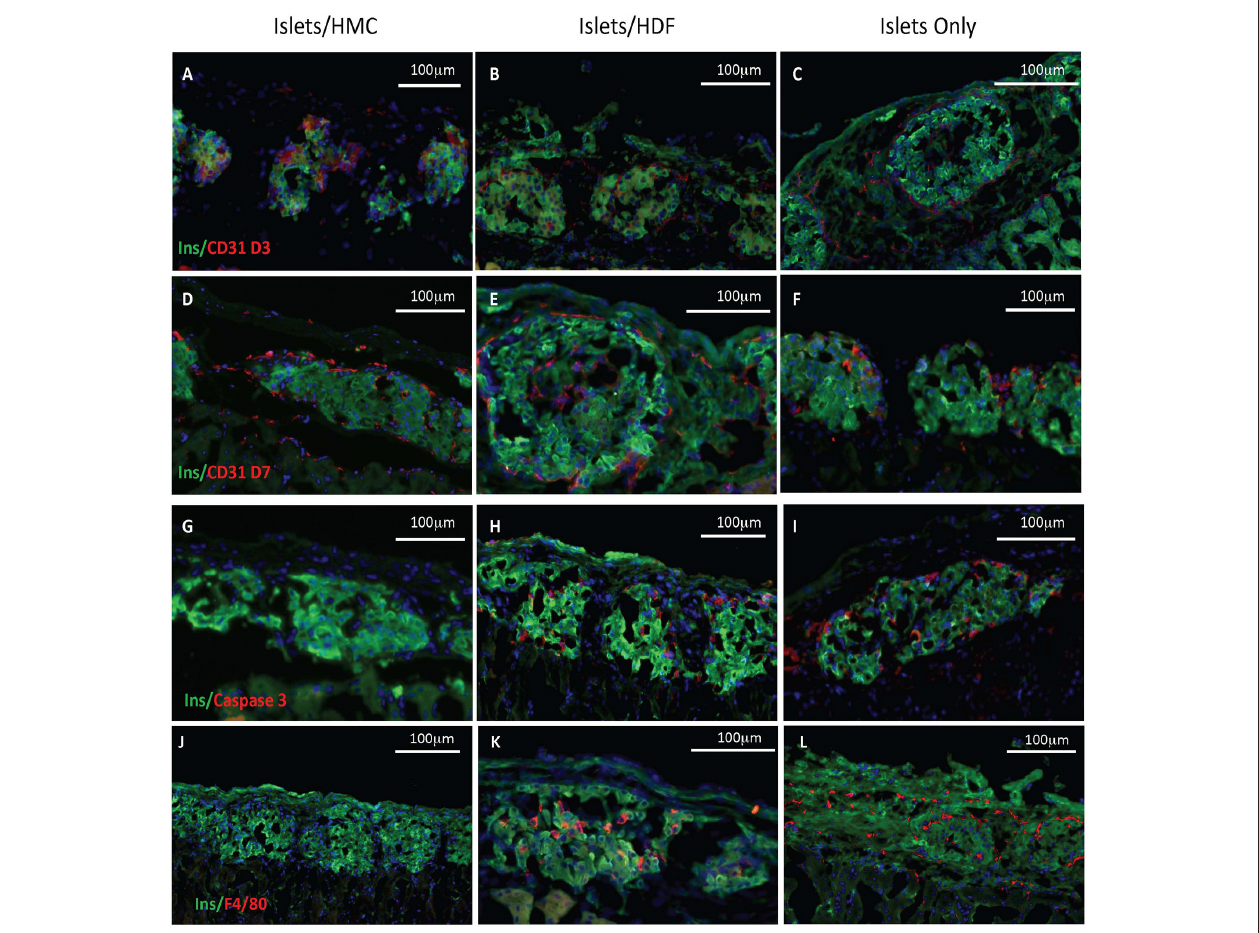
FIGURE 3 | Histological features of the islet grafts. Tissues retrieved from recipients of islets plus HMCs are shown in the left column (A,D,G,J) , whereas tissues from recipients of islets plus HDFs are shown in the middle column (B,E,H,K ) and from Islets Only in the right column (C,F,I,L) . Insulin immunofluorescence is in green, nuclei in blue. (A–F) CD31, a marker of endothelium is shown in red. (A–C) Day 3 post-transplant. (D–F) Day 7 post-transplant. (G–I) Caspase 3, a marker of apoptosis, is shown in red on day 3 post-transplant. (J–L) F4/80, a marker for macrophages, is shown in red on day 7 post-transplant. Magnification 200 ×